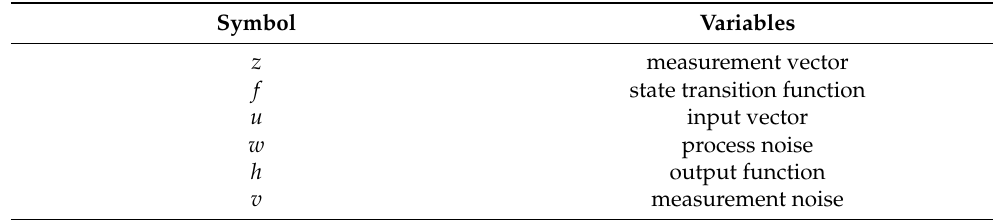
Table 2. The parameters of Equation (8).